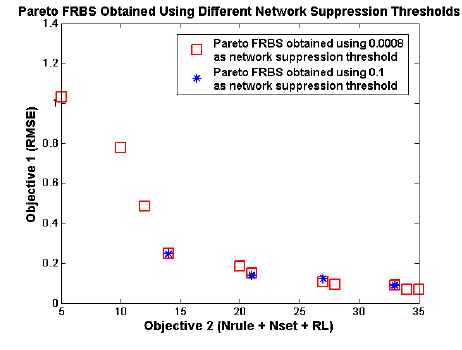
Fig. 12. Pareto FRBS obtained using different .